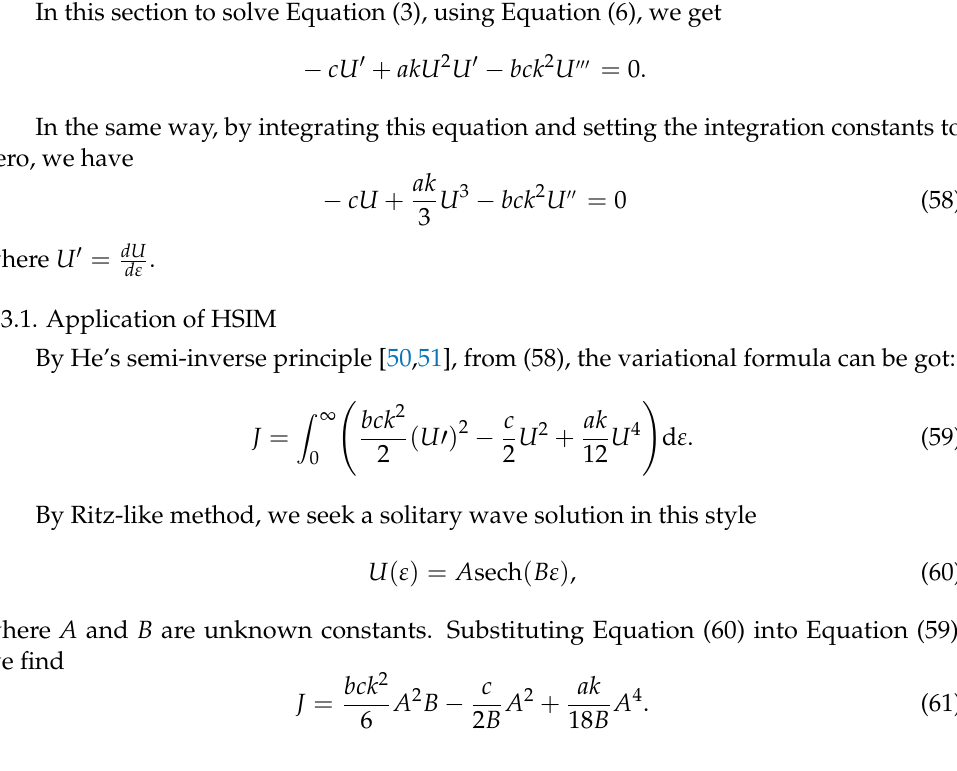
Figure 2. Graph of the solution u ( x , t ) for the values β = 0.25, 0.5 and 0.75 when a = 3, b = − 1, k = c = 1.